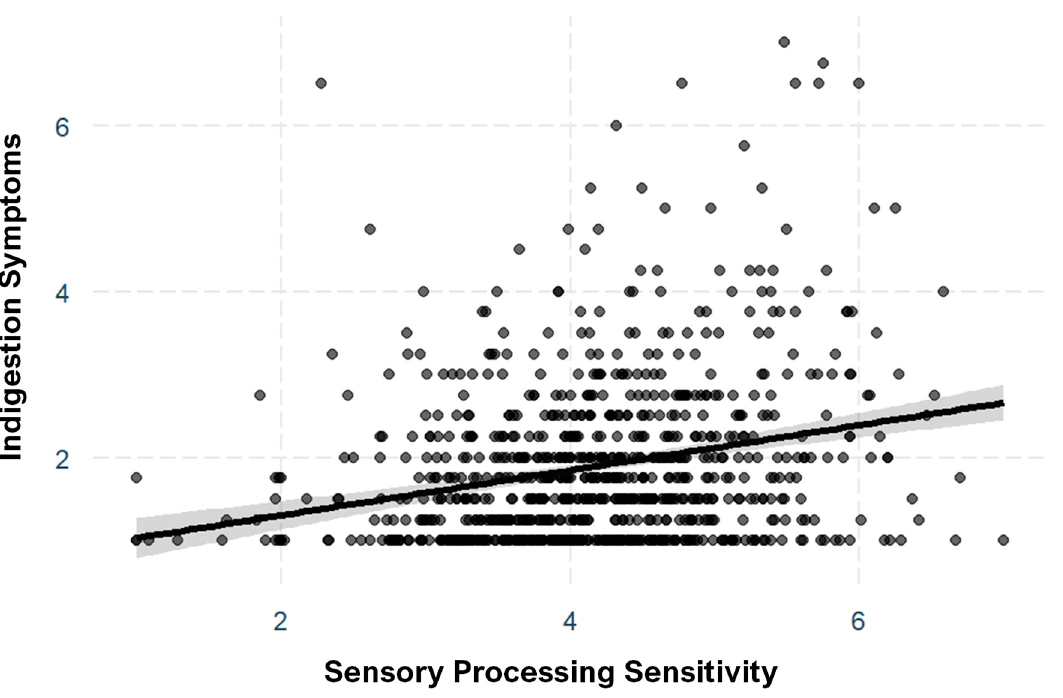
Figure A3. A Plot of the Regression Line Showing the Relationship between the Indigestion Symptoms and Sensory Processing Sensitivity.